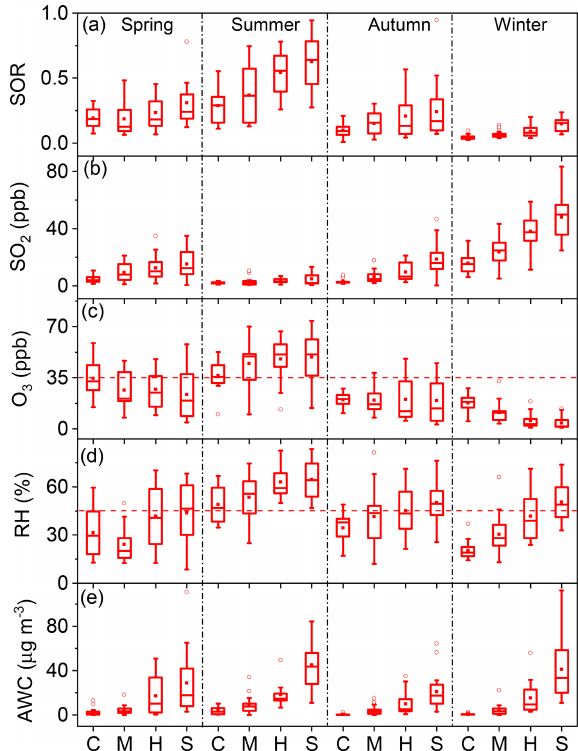
Figure 11. Variations in (a) SORs, (b) SO 2 , (c) O 3 , (d) RH, and (e) AWC with pollution levels in each season. C, clean; M, mod- erate pollution; H, heavy pollution; S, severe pollution. The boxes represent, from top to bottom, the 75th, 50th, and 25th percentiles for each pollution level. The whiskers, solid red squares, and open red circles represent 1.5 times the IQR, mean values, and outlier data points, respectively. The horizontal dashed lines in panels (c) and (d) represent thresholds of O 3 = 35ppb and RH = 45%, re-